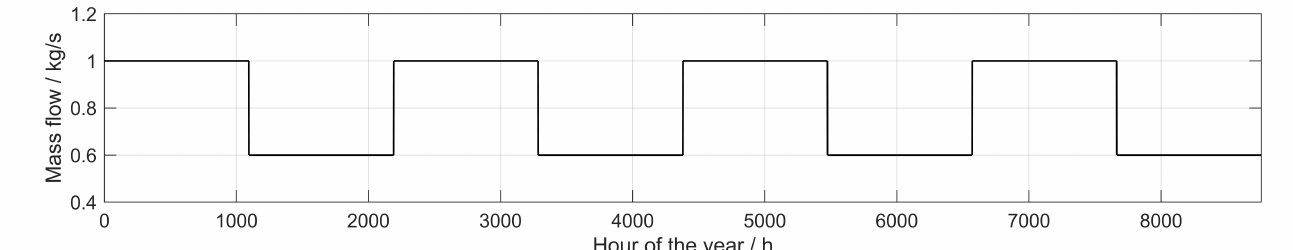
Figure 7. Mass flow for one of the 349 in parallel connected probes within the BTES with the corresponding Re–Numbers of Re = 1.03 × 10 4 and Re = 1.72 × 10 4 .